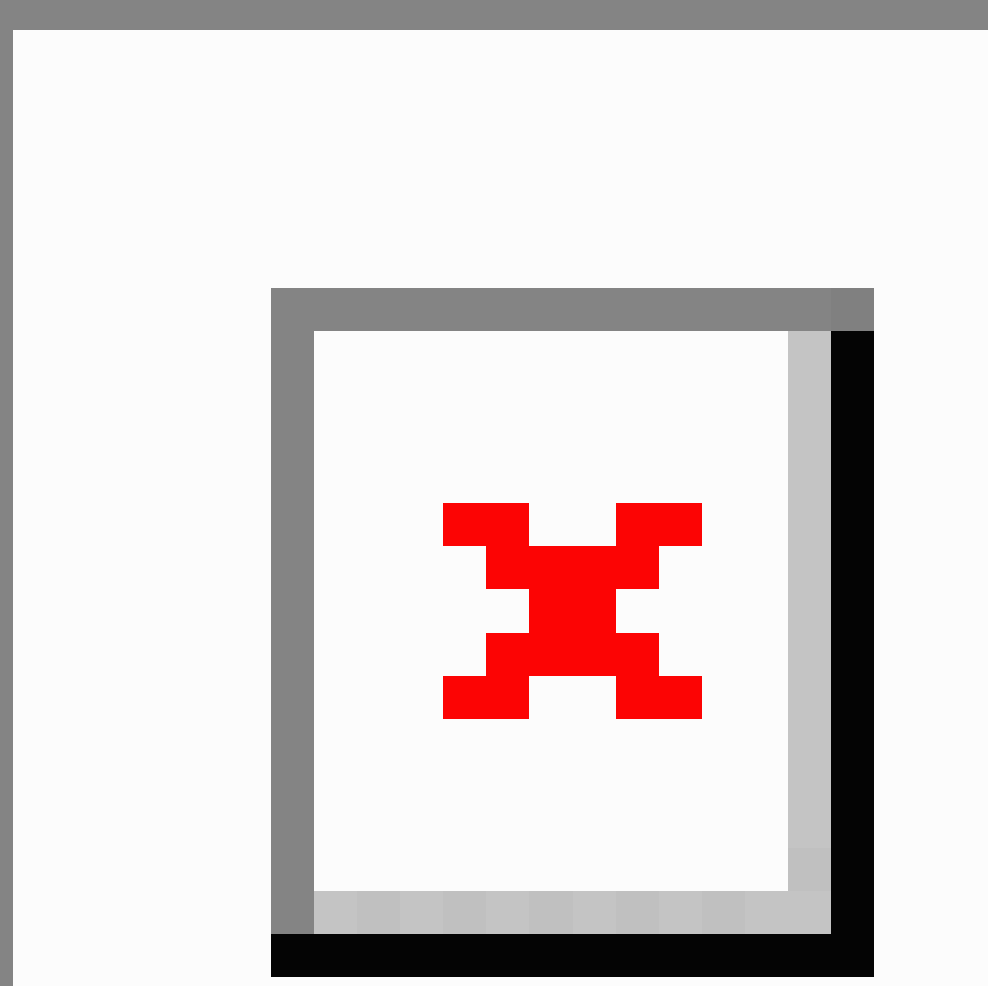
Figure 3. The Library (Helsebiblioteket.no) pageviews and time of day of patient information leaflets (PI) in